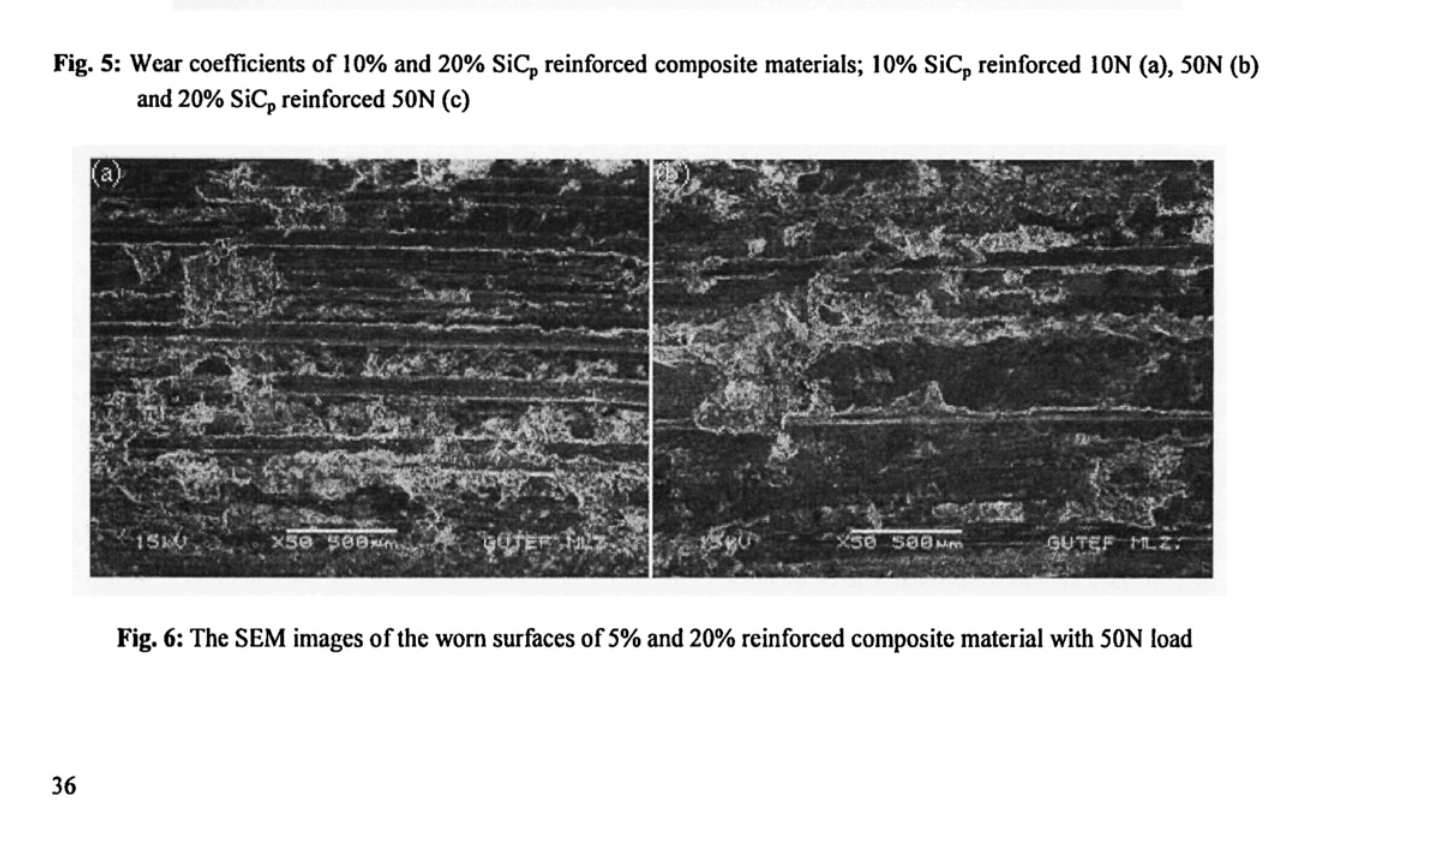
reinforced composite materials; 10% SiC p